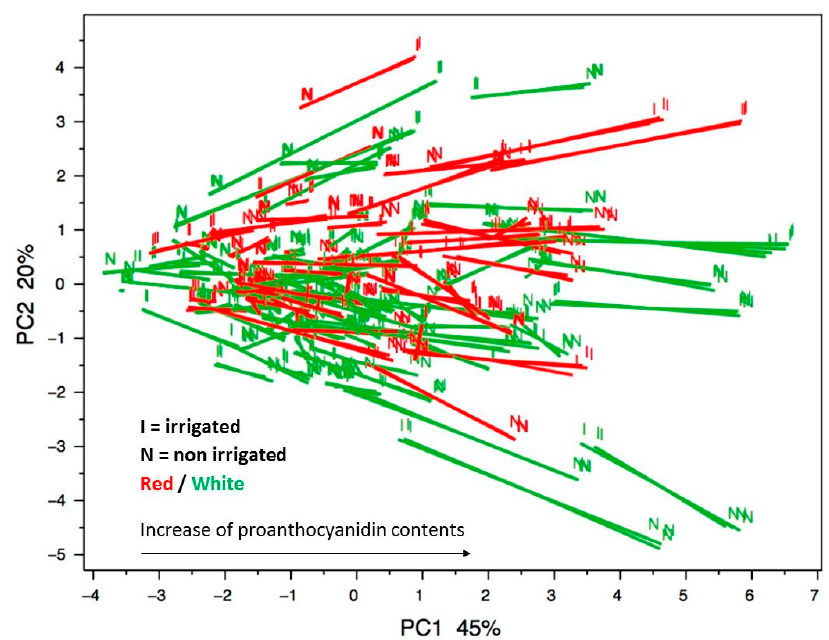
Figure 4. Projection of the grape samples on the first two principal components of the PCA performed on the skin flavan-3-ol composition data (C up , EC up , EGC up , ECG up , C term , EC term , GC term , EGC term and ECG term ; mg/g berry skin; centred reduced